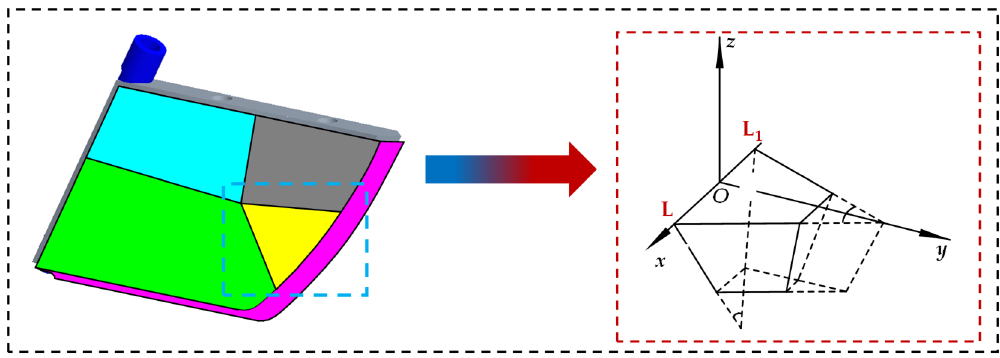
Figure 13. Schematic diagram of the extruded soil surface structure.